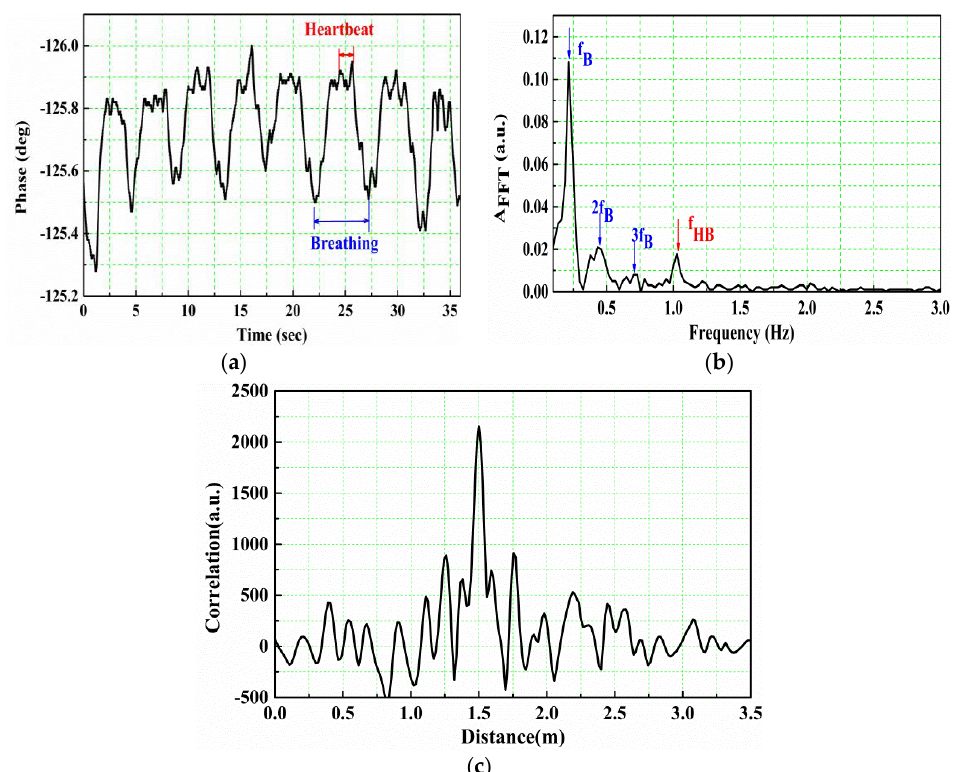
Figure 4. Experimental results of the target at the 1.5 m away from the antennas. ( a ) Raw phase data; ( b ) The FFT amplitude as a function of frequency obtained by performing FFT on the raw phase data; ( c ) Ranging result.